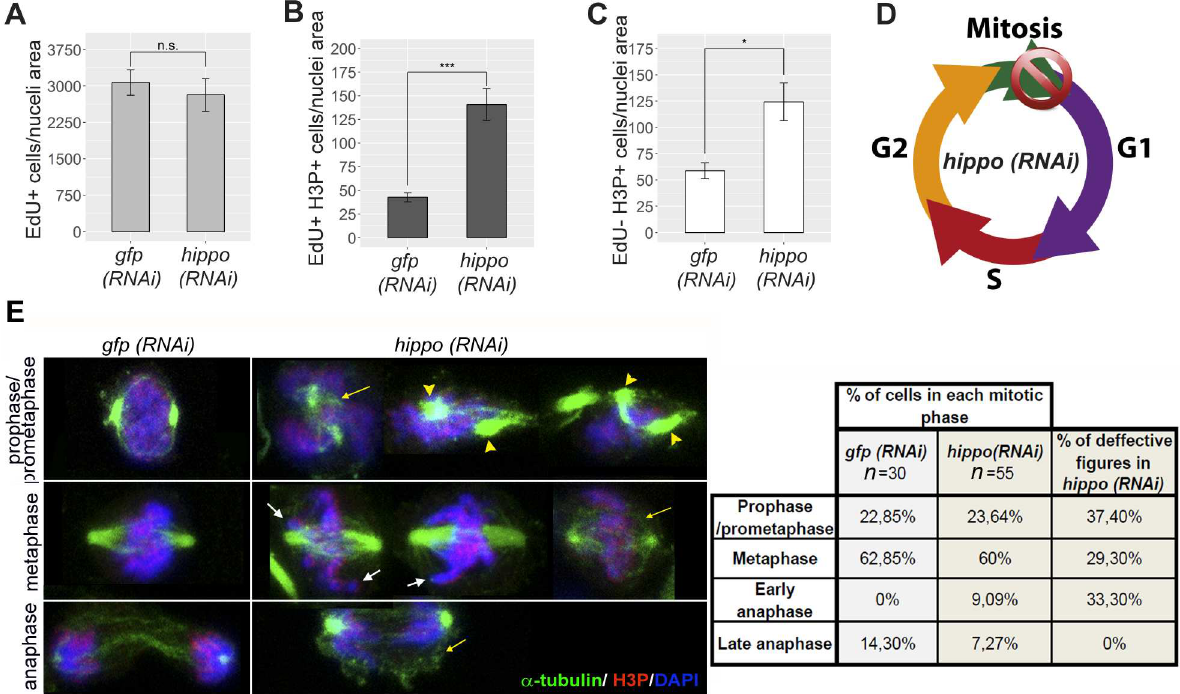
Fig 2. hippo plays a pivotal role during the cell cycle. (A) Quantification of EdU+ cells in hippo (RNAi) animals and corresponding controls. (B) Quantification of double-positive EdU+/H3P+ cells in hippo (RNAi) animals and corresponding controls. (C) Quantification of EdU − /H3P+ cells in hippo (RNAi) animals and corresponding controls. Experiments were performed after a 16-h EdU pulse. All graphs correspond to animals subjected to hippo RNAi for 3 weeks ( n (cid:21) 8). Error bars represent standard deviation. Data were analyzed by Student t test. (cid:3) p < 0.05; (cid:3)(cid:3)(cid:3) p < 0.001. (D) Schematic showing the proposed function of hippo during the cell cycle in planarians: hippo attenuates G2/M progression and ensures successful mitotic exit. (E) α -tubulin arrangement in hippo (RNAi) and control cells, as revealed by double immunostaining with anti- α -tubulin and anti-H3P. Nuclei are stained with DAPI. The percentage of each mitotic phase and of defective figures found in hippo (RNAi) cells is shown in the table. Yellow arrows indicate disorganized and less dense arrays of spindle microtubules; yellow arrowheads indicate mislocalized poles; white arrows indicate unaligned chromosomes. Data used in the generation of this figure can be found in S1 Data. Scale bar: 10 μ m. EdU, 5-ethynyl-2 0 -deoxyuridine; gfp , green fluorescent protein ; H3P, phospho-histone-H3-Ser10; n.s., not significant; RNAi, RNA interference.